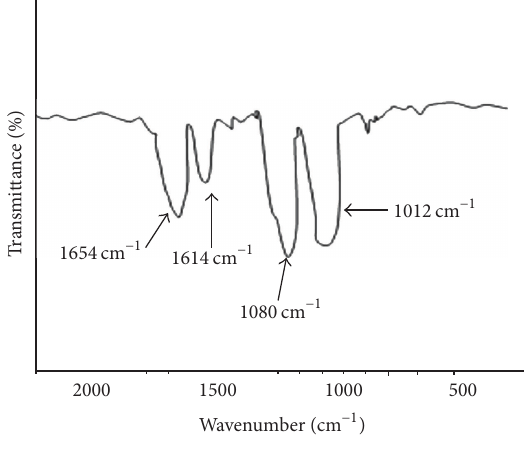
F 7: FTIR spectrum of AgNPs synthesized by Tulsi extract.